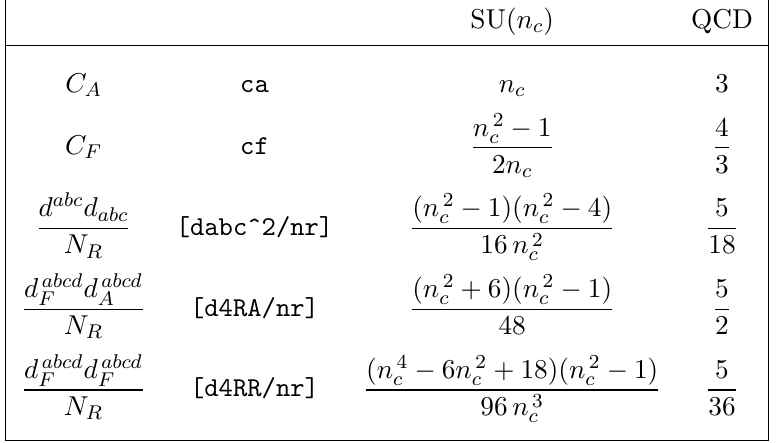
Table 1 . The colour factors for non-singlet OMEs up to four loops with their numerical values in SU( n c ) with N R = n c and QCD, see also ref. [78] for a discussion on the normalization of d abc d abc . The second column gives the notations of the result (cid:12)les, which are distributed with this article SU( n c )) which can be readily